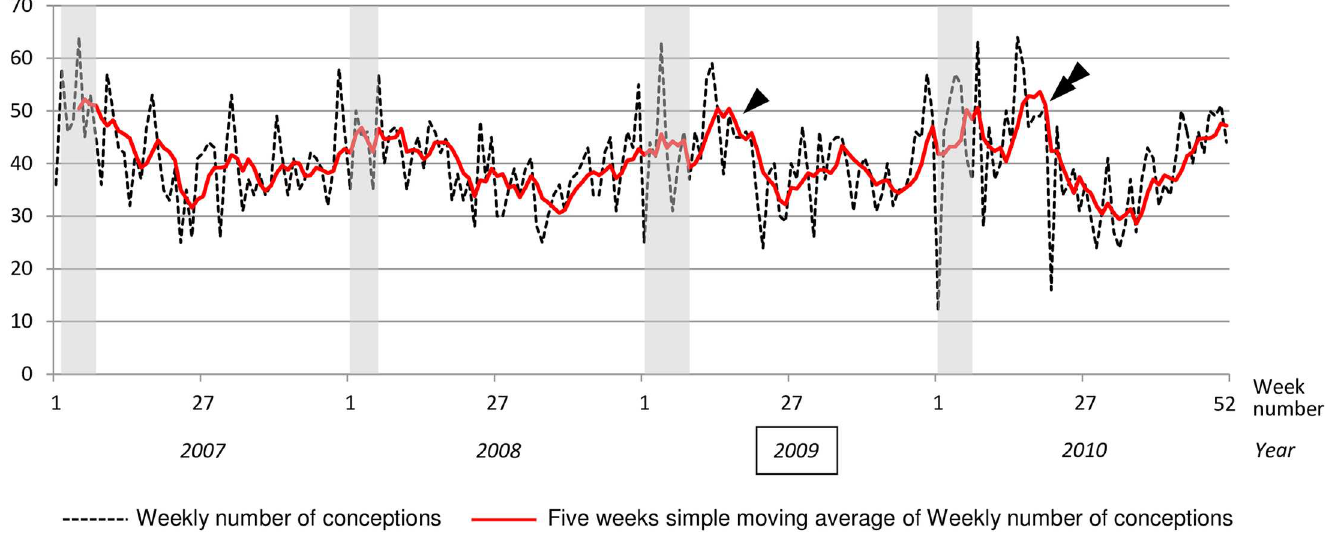
Fig 2. Weekly number of conceptions in Guadeloupe (French West Indies) from January 1 2007 through December31, 2010. Shadedareas: periodsof conceptions initiatedduringthe carnivalperiodof the same year. Arrow: peak of weeklynumbersof conceptions that followsthe periodof canceled2009 carnival.Doublearrow: peak of weekly numbers of conceptions that follows the periodof 2010